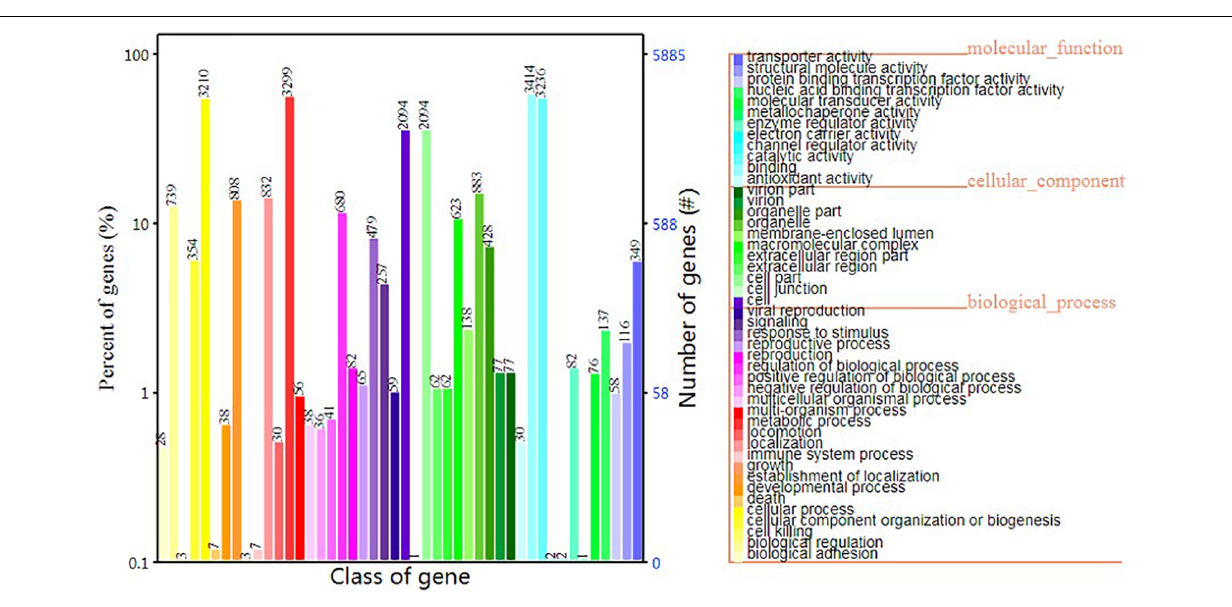
FIGURE 6 | Gene Ontology functional annotation of Sarcomyxa edulis